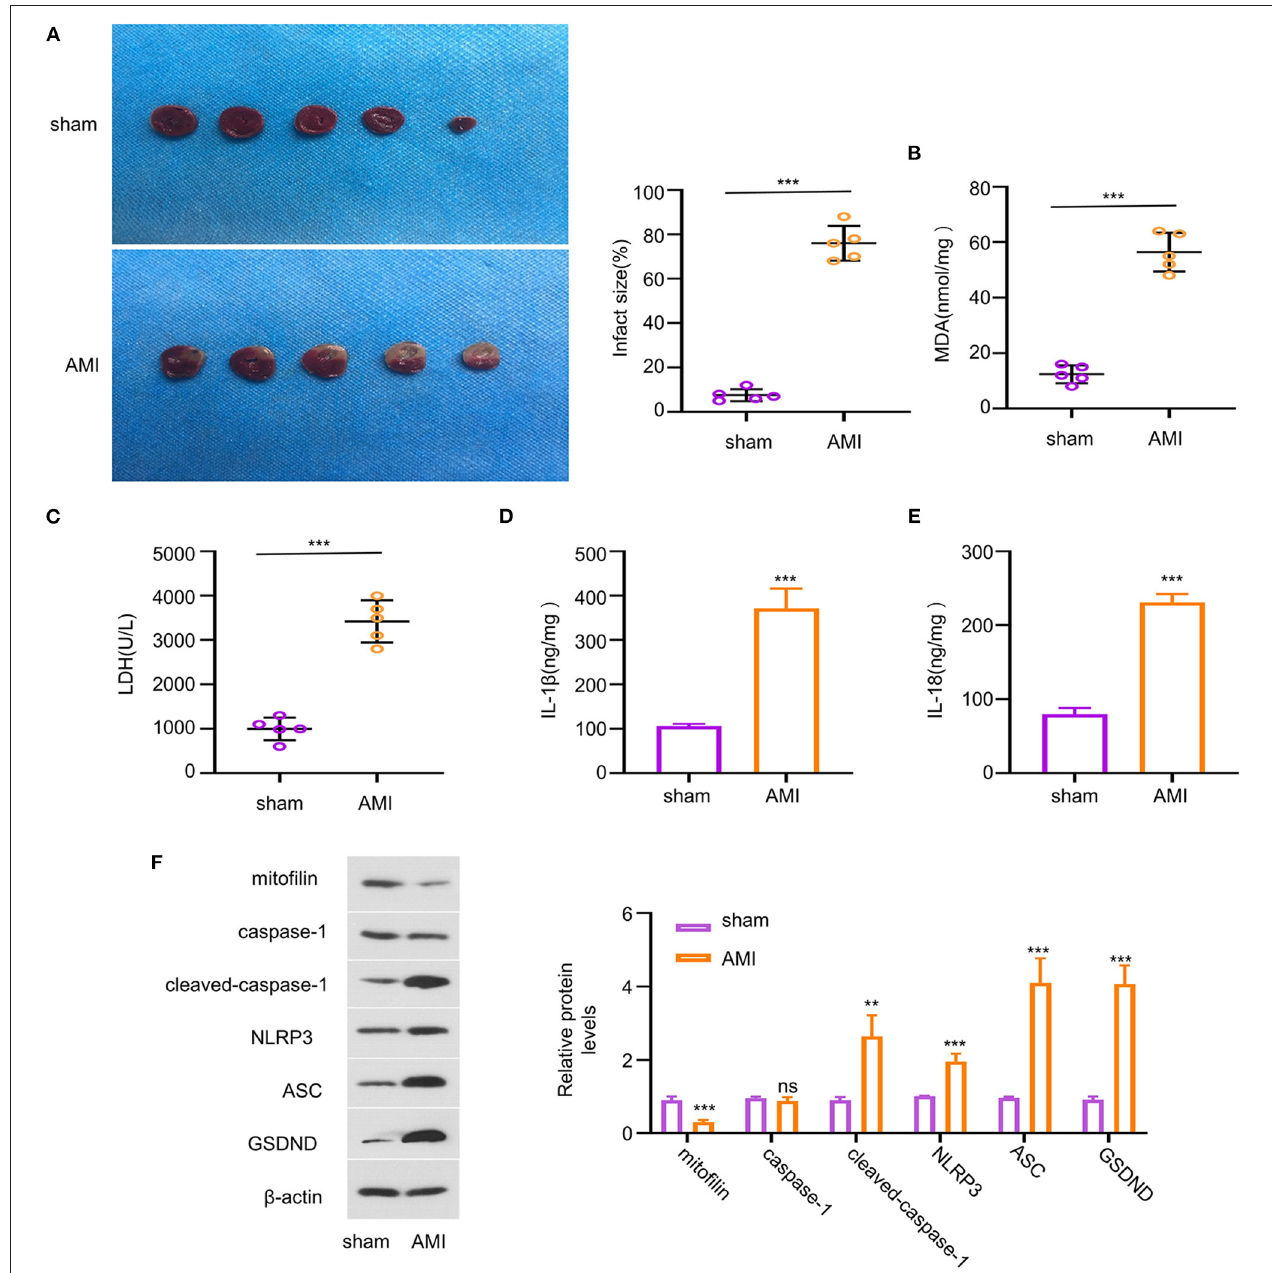
FIGURE 1 | Reduced mitofilin expression is associated with the upregulation of pyroptosis-related factors in an acute myocardial infarction (AMI) model. (A) The percentage of myocardial infarction (MI) area increased in the AMI group. (B,C) The malondialdehyde (MDA) level and the lactate dehydrogenase (LDH) level were increased upon AMI induction. (D,E) The levels of interleukin (IL)-1 β and IL-18 were increased in the AMI group. (F) Mitofilin protein levels were significantly decreased in the AMI group, while the protein levels of cleaved-caspase-1, nucleotide-binding oligomerization domain-like receptor pyrin domain-containing 3 (NLRP3), apoptosis-associated speck-like protein containing (ASC), Gasdermin D (GSDND) were increased. ** p < 0.01 and *** p < 0.001. ns: not significant.